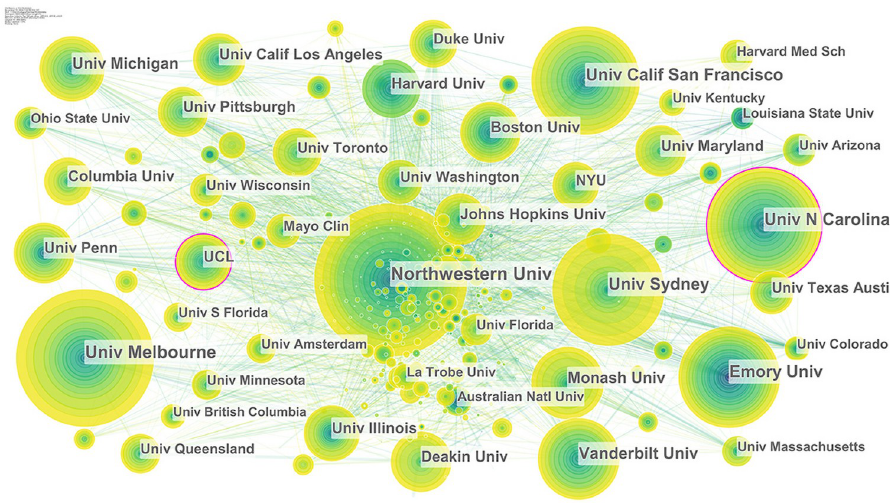
Fig 4. Institution collaboration network of health literacy. Each node represents an institution, and the size of the node indicates the number of publications of the institution. Each edge indicates a collaborative relationship between two